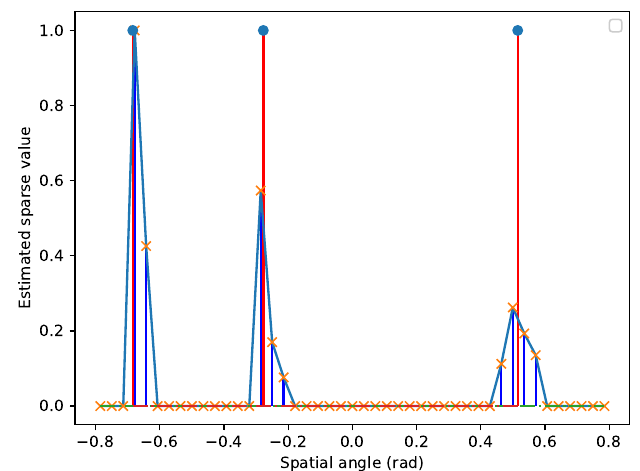
Figure 11. The reconstructed sparse signal using AtomicNet and infinite precision ADC, where the red line denotes the ground-truth DOA and the blue line denotes the estimated spatial spectrum.